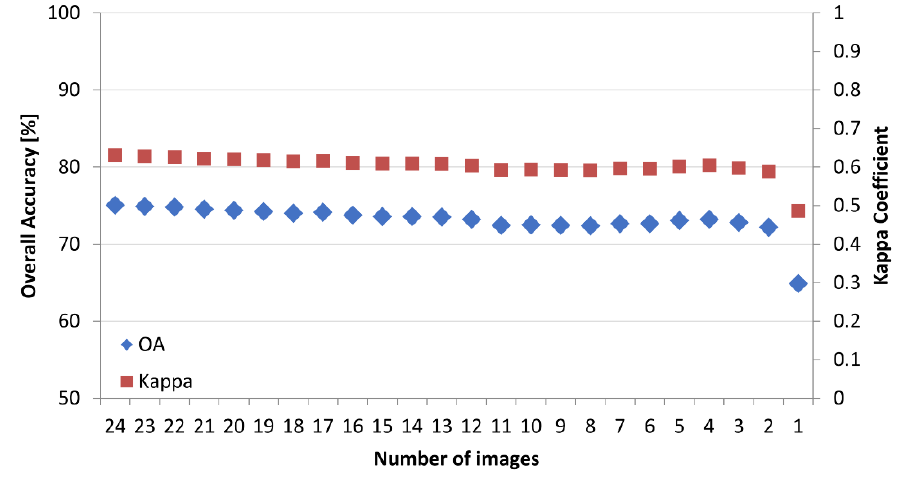
Figure 15. Overall Accuracy (AO) and Kappa Coefficient for each classification run based on a decreasing number of images.